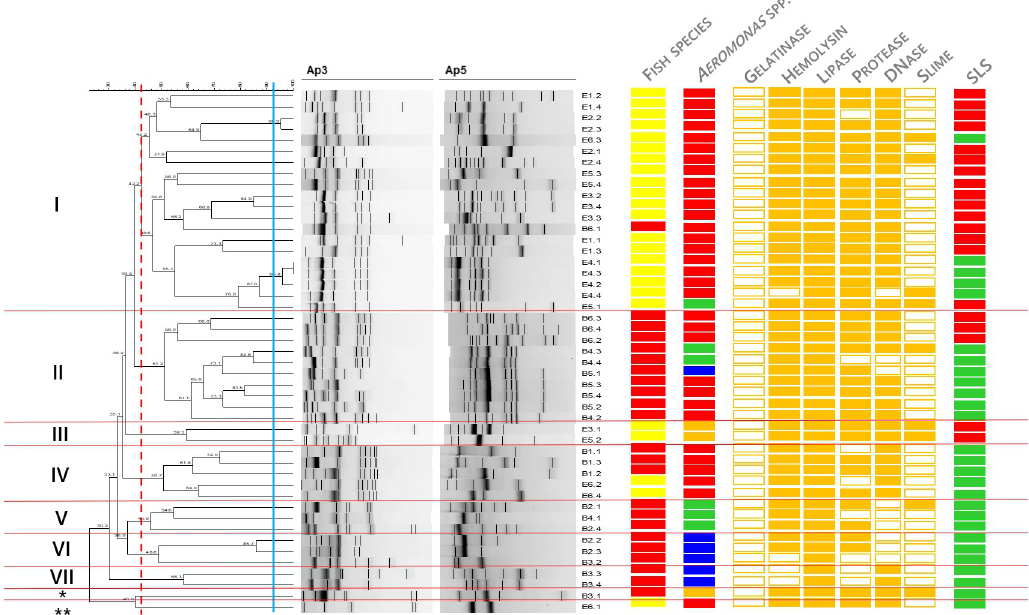
Fig 5. Dendrogram based on the composite analysis of the isolates´ RAPD fingerprints with primers Ap5 and Ap3, using the Dice similarity coefficient. Clustering was achieved with UPGMA. Blue line represents reproducibility level (92.3%) and isolates displaying higher similarity levels were considered identical. Red dash line represents cluster level (42.2%). Red lines are presented for an easy visualization of the defined clusters. Cophenetic correlation coefficient was 0.74. First column represents isolate’s identification, second the fish species (yellow– S . pyrenaicus , red– I . lusitanicum ), third the Aeromonas species (red– A . hydrophila , green– A . caviae , blue– A . media , orange– A . veronii ), fourth to ninth the virulence factors (gelatinase, hemolysin, lipase, protease, DNase, slime; empty rectangle–negative, full rectangle–positive) and the tenth the skin lesion score (SLS) [red– high ( > 5.4%), green–low ( >